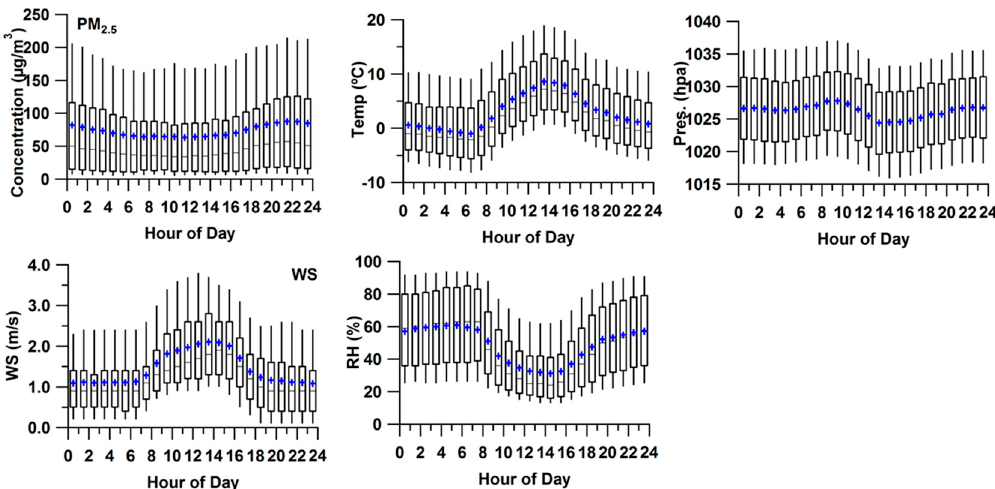
Figure A2. Diurnal of PM 2.5 and meteorological variables for the entire study.